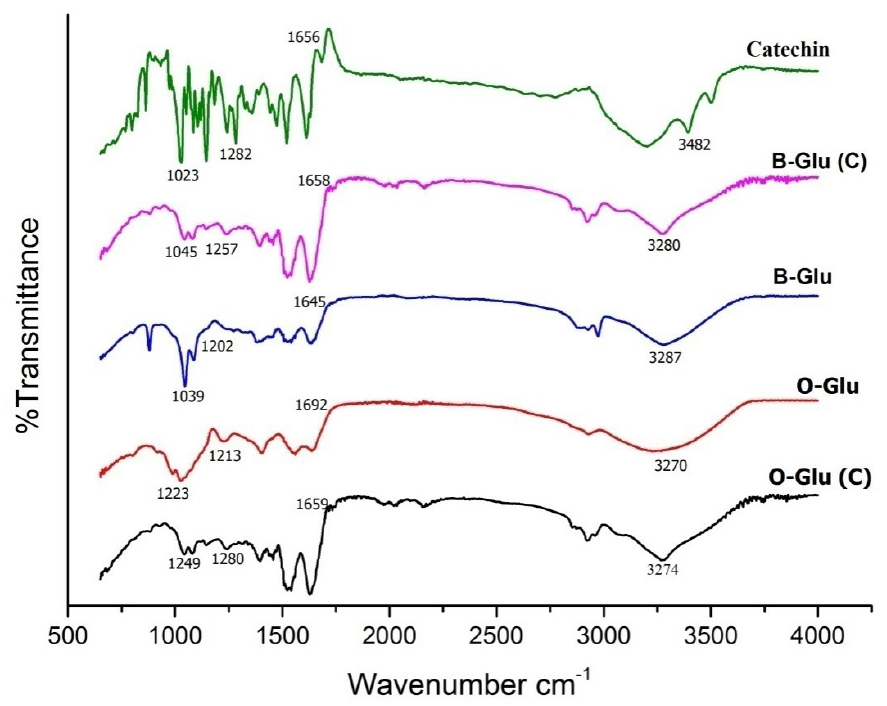
Figure 1. The FT-IR spectrum of catechin, B-Glu (C), B-Glu, O-Glu (C), O-Glu. B-Glu (C) represents catechin encapsulated in barley β -glucan, O-Glu (C) catechin encapsulated in oats β -glucan, B-Glu represents barley β -glucan, and O-Glu represents oats β